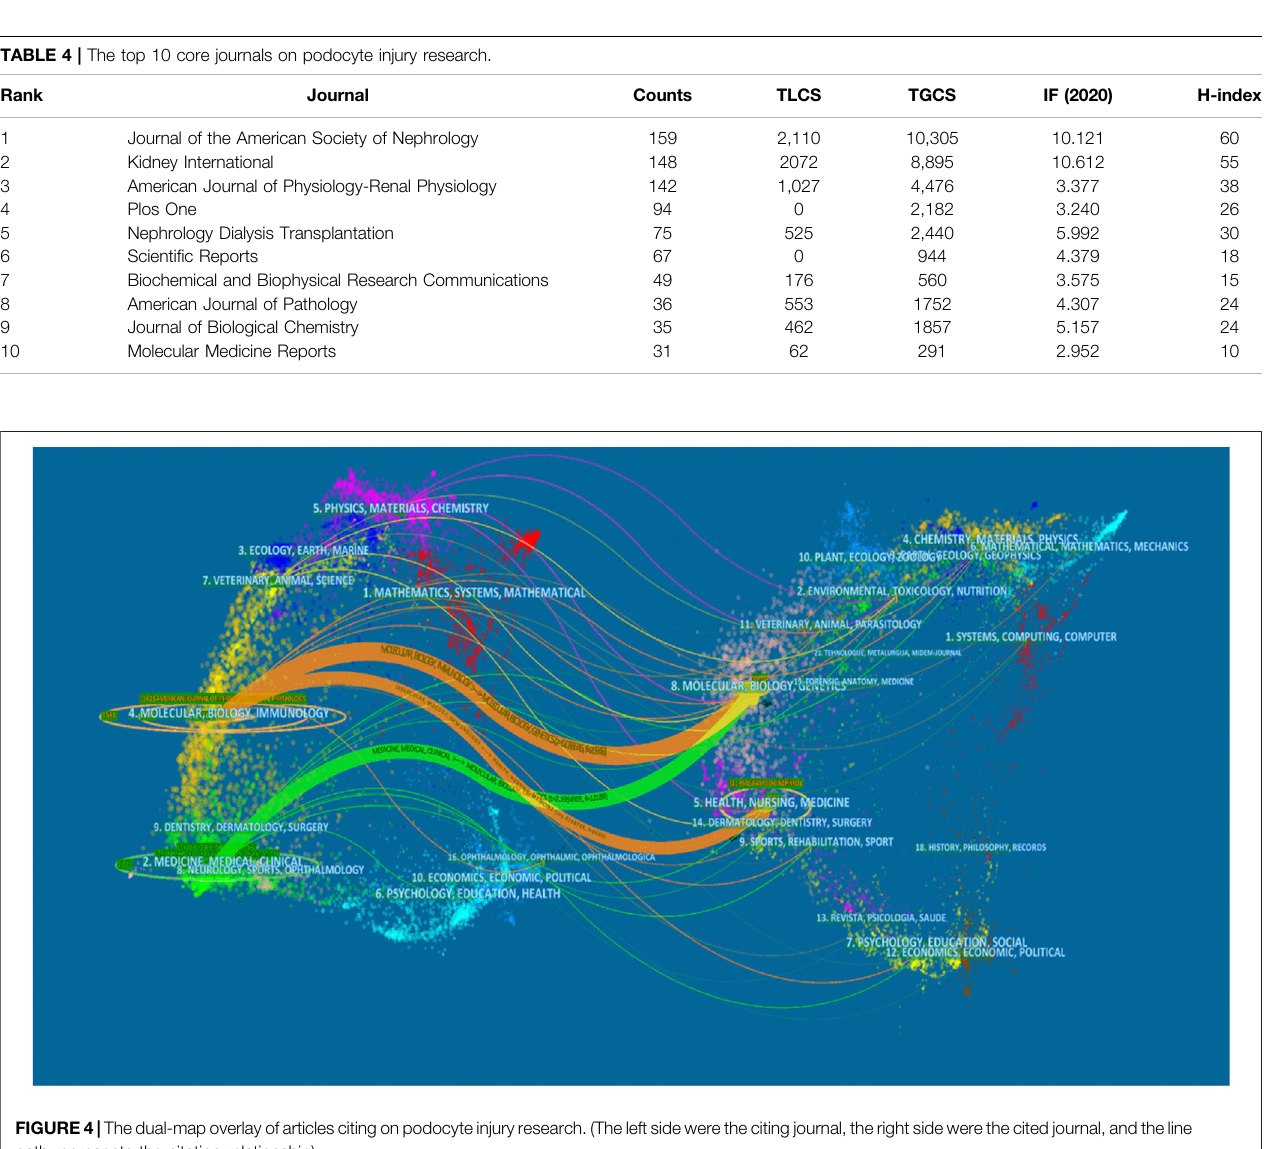
Frontiers in Pharmacology |